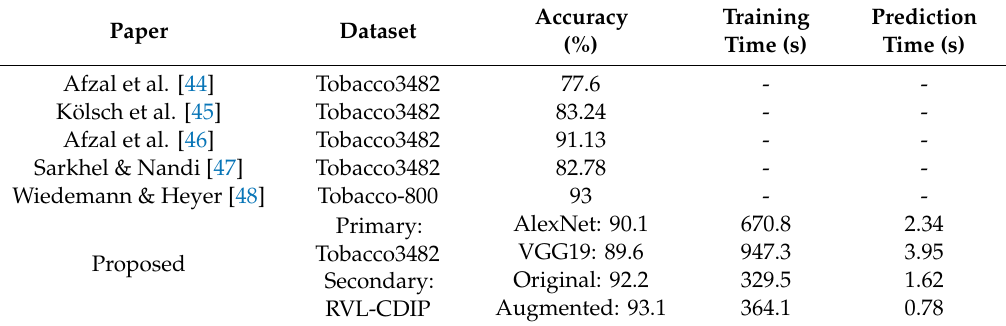
Table 7. Comparison with existing techniques on the Tobacco3482